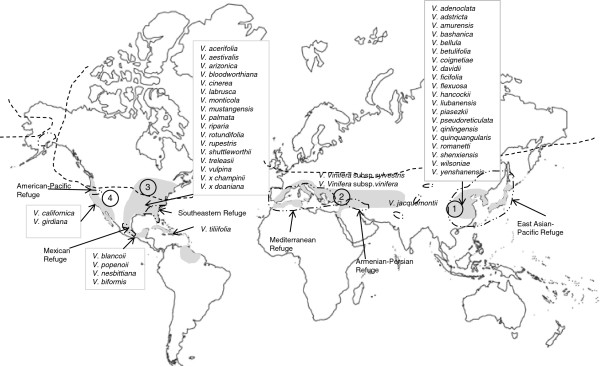
Native geographic distribution of the genus Vitis (grey shading1) and geographic regions of origin of Vitis species used in this study. Dashed lines indicate southern borders of the polar ice cap during the most recent ice age2. Dash-dot lines indicate ice age refugia of the forest flora2. Areas labeled 1 through 4 were used in ancestral area optimization (reversible parsimony, Additional file 14). Redrawn from 1Alleweldt et al. [7], 2Reinig [14].